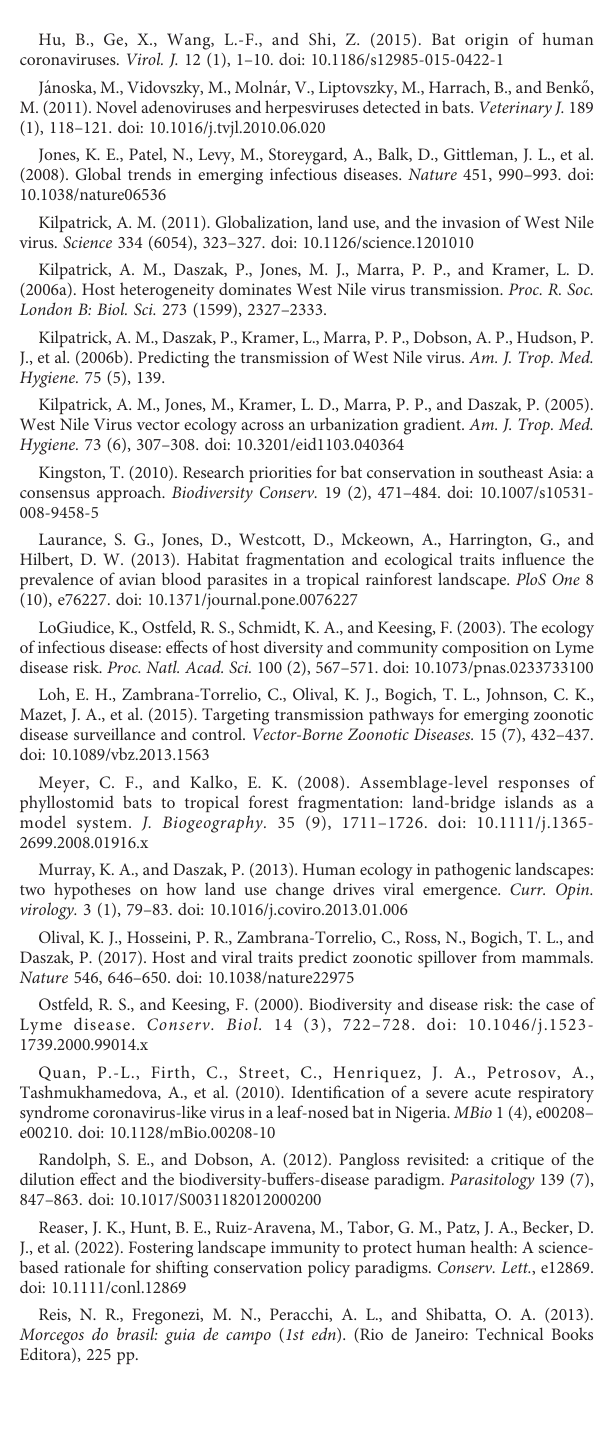
SUPPLEMENTARY FIGURE 5 HantavirusMaximumLikelihood PhylogeneticTree.Geneticanalysisof89 nucleotide partial S segment. Tree reconstructed by MEGA7 with heuristic search, Neighbor-Joining “ NJ ” algorithm and Model GTR+gamma+I. The principal node values superior to 70% represent 1,000 bootstrap